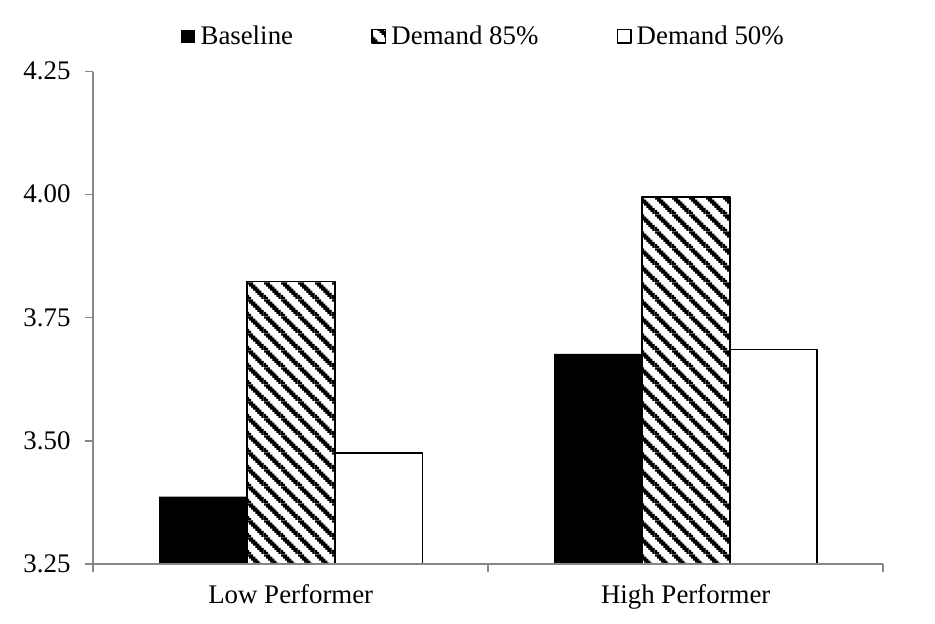
Figure 1: Summary of competence evaluations, study